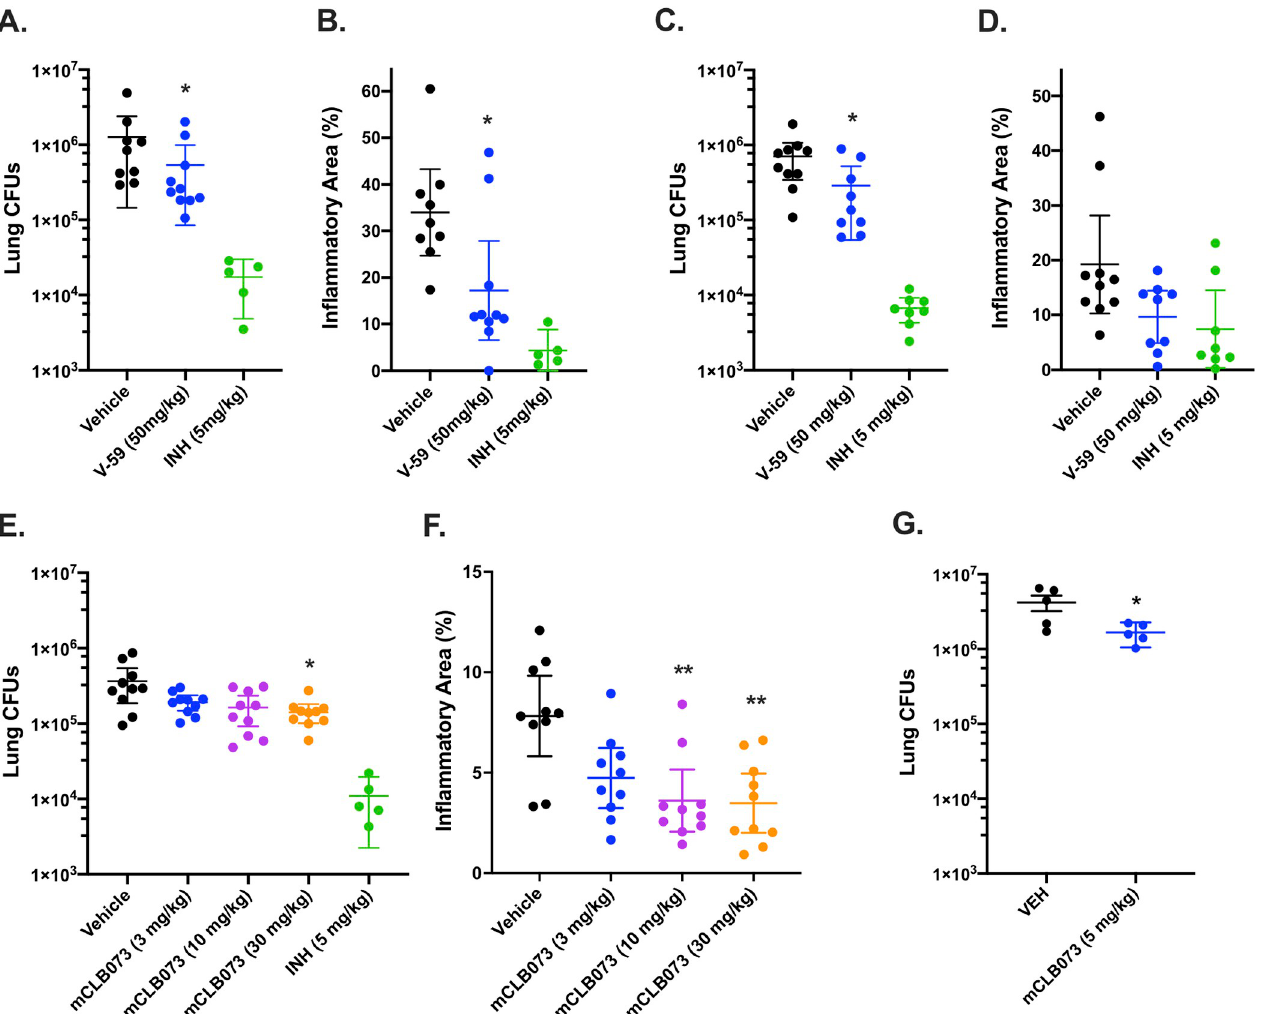
Fig 9. Chemically activating Rv1625c reduces Mtb pathogenesis in vivo . Effect of V-59 treatment on bacterial burden and pathology in the lungs of BALB/c ( A and B ) or C3HeB/FeJ mice ( C and D ). In ( A-D ) mice were infected and treated with V-59, INH, or vehicle control. Data are from two independent experiments with 5 mice ( A and B ), or one experiment with 10 mice ( C and D ) per group. Outliers with CFUs below the infectious dose were excluded from the analyses ( � P < 0.05, Mann-Whitney test). ( E and F ) Impact of mCLB073 treatment on bacterial burden ( E ) and pathology ( F ) in BALB/c mice infected and treated with the indicated doses of mCLB073, INH, or vehicle control ( � P < 0.05, �� P < 0.01, Kruskal-Wallis test and Dunn’s multiple comparisons test). Infections in ( A-F ) were by the intranasal route. Data are from one experiment with 10 mice per group. ( G ) Impact of mCLB073 treatment on bacterial burden in BALB/c mice infected by aerosol and treated with 5mg/kg mCLB073 or vehicle control. Data are from one experiment with 5 mice per group ( � P < 0.05, Kruskal-Wallis test and Dunn’s multiple comparisons test). All data are shown as means ± SEM.